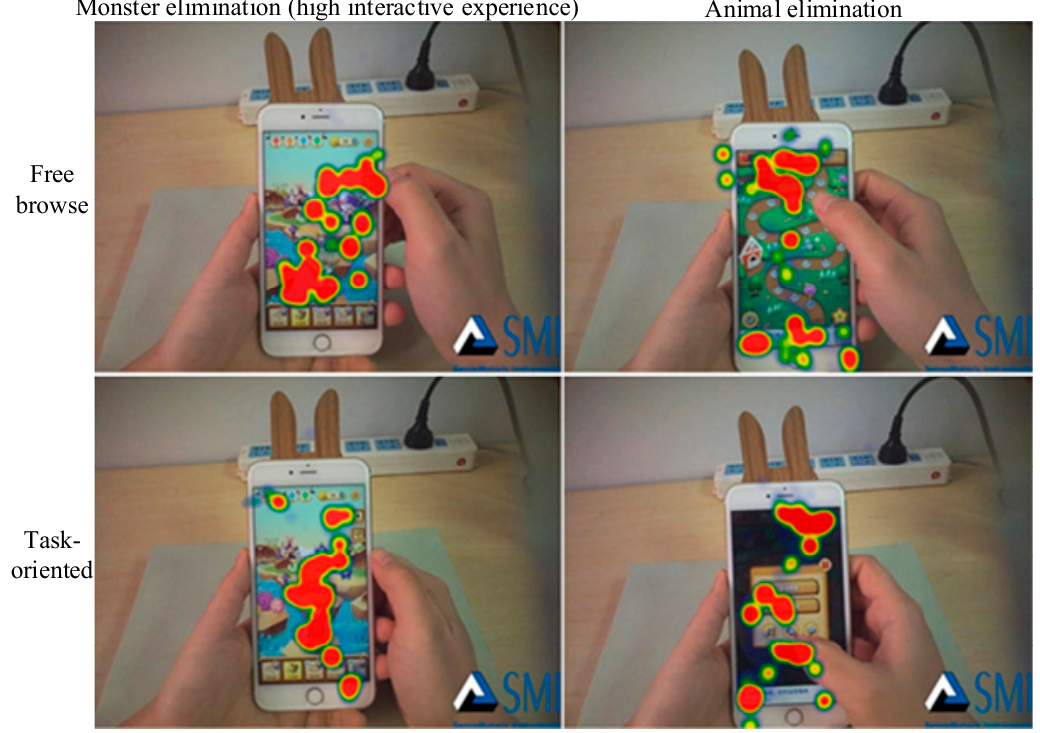
Figure 4. The heat map of two experimental modes.